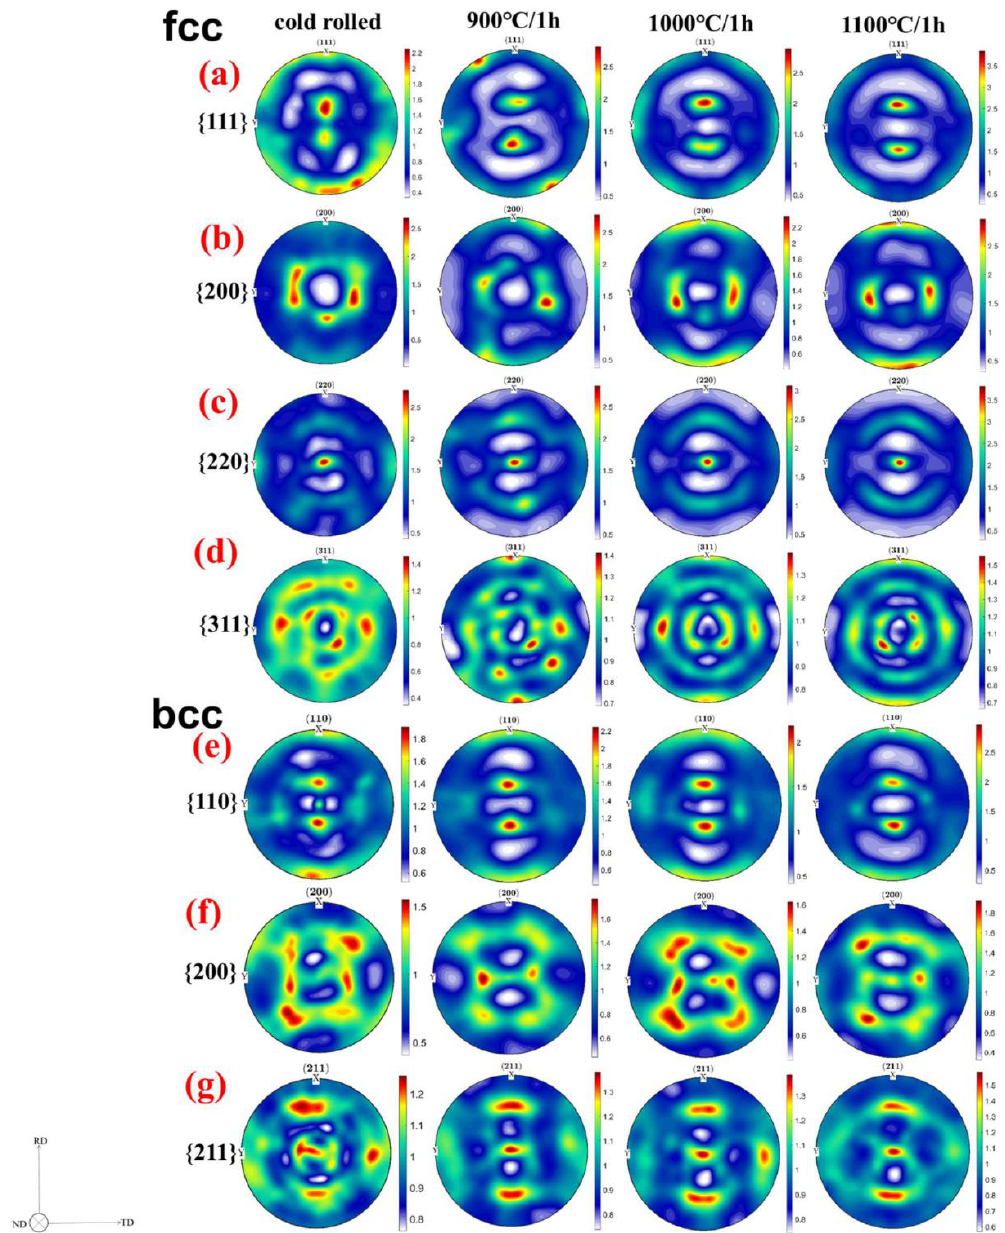
Figure 3. The complete pole figures indicate the intensities of ( a ) {111}, ( b ) {200}, ( c ) {220}, ( d ) {311}, ( e ) {110}, ( f ) {200}, and ( g ) {211} in the cold-rolled state and the annealed states at 900 °C, 1000 °C, and 1100 °C in the fcc phase and bcc phase. Note that x and y represent RD and TD, respectively.